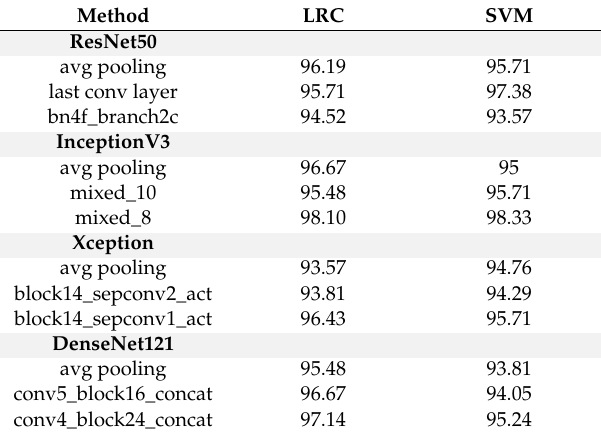
Table 1. The classification accuracy (OA (%)) of linear classification with a Logistic Regression Classifier (LRC) and a Support Vector Machine (SVM), using features extracted from di ff erent layers with 80% of UC-Merced dataset as a training